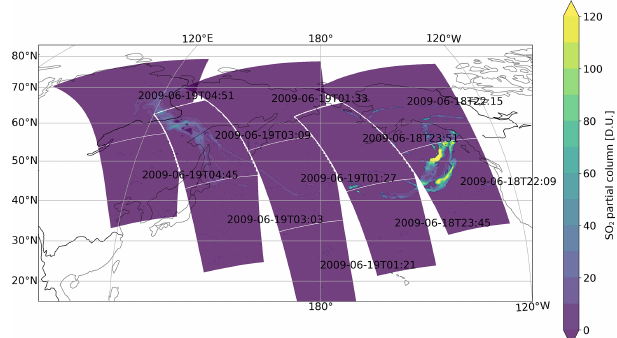
Figure 2. SO 2 partial column densities from AIRS swaths on 18 and 19 June. The total SO 2 mass is 1.09Tg, with no location counted more than